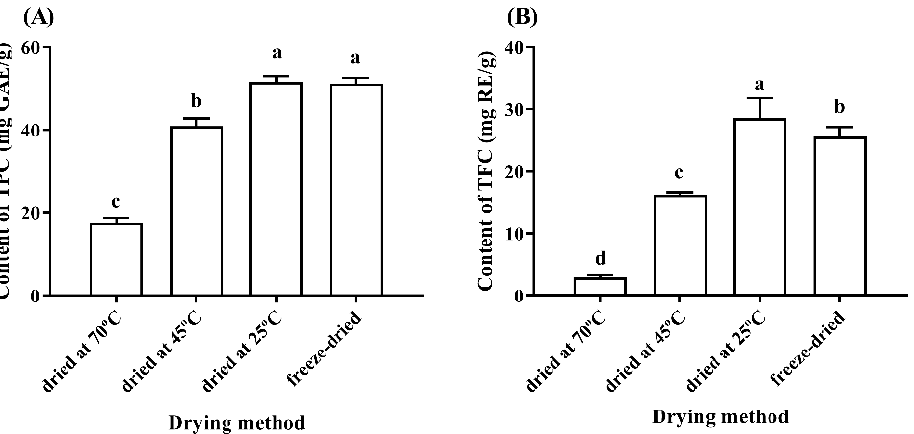
Figure 2. Contents of TPC ( A ) and TFC ( B ) in olive leaves after drying in an oven at 70 and 45 °C, room temperature (25 °C) and freeze dryer, respectively. Values are the mean of triplicate experiments, and the error bar indicates the standard error of duplicate data. Significance data were obtained by analysis of variance (ANOVA). Different lowercase letters (a, b, c and d) on the top of columns represent significant difference ( p < 0.05).